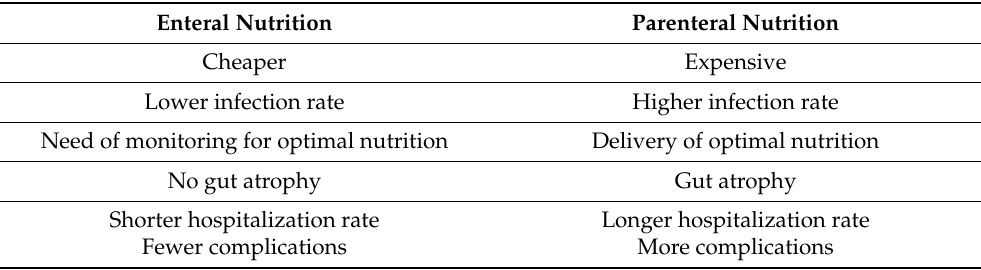
Table 1. Main characteristics and differences between enteral and parenteral